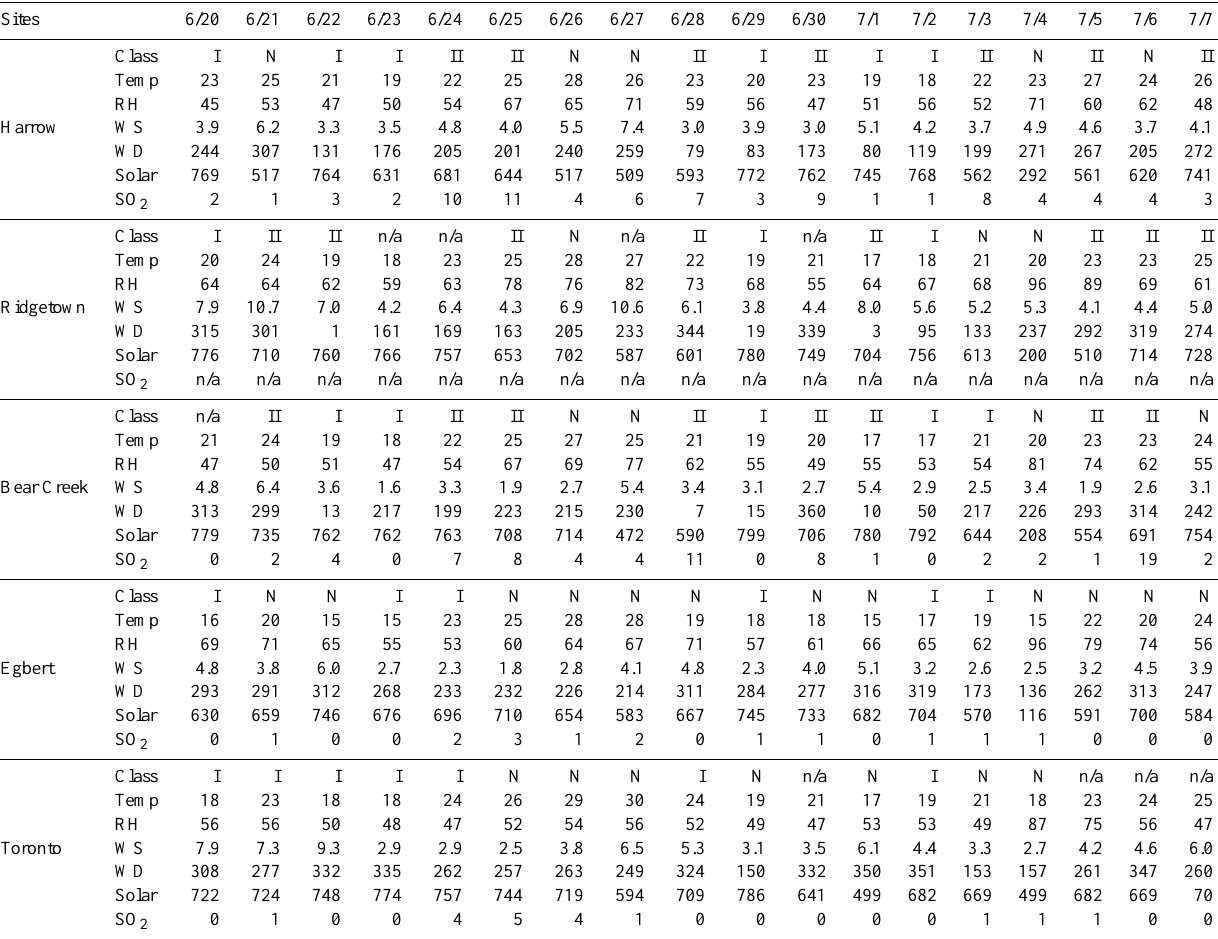
Table 3. Classification of particle formation events and average values of selected parameters between 07:00a.m. and 03:00p.m.